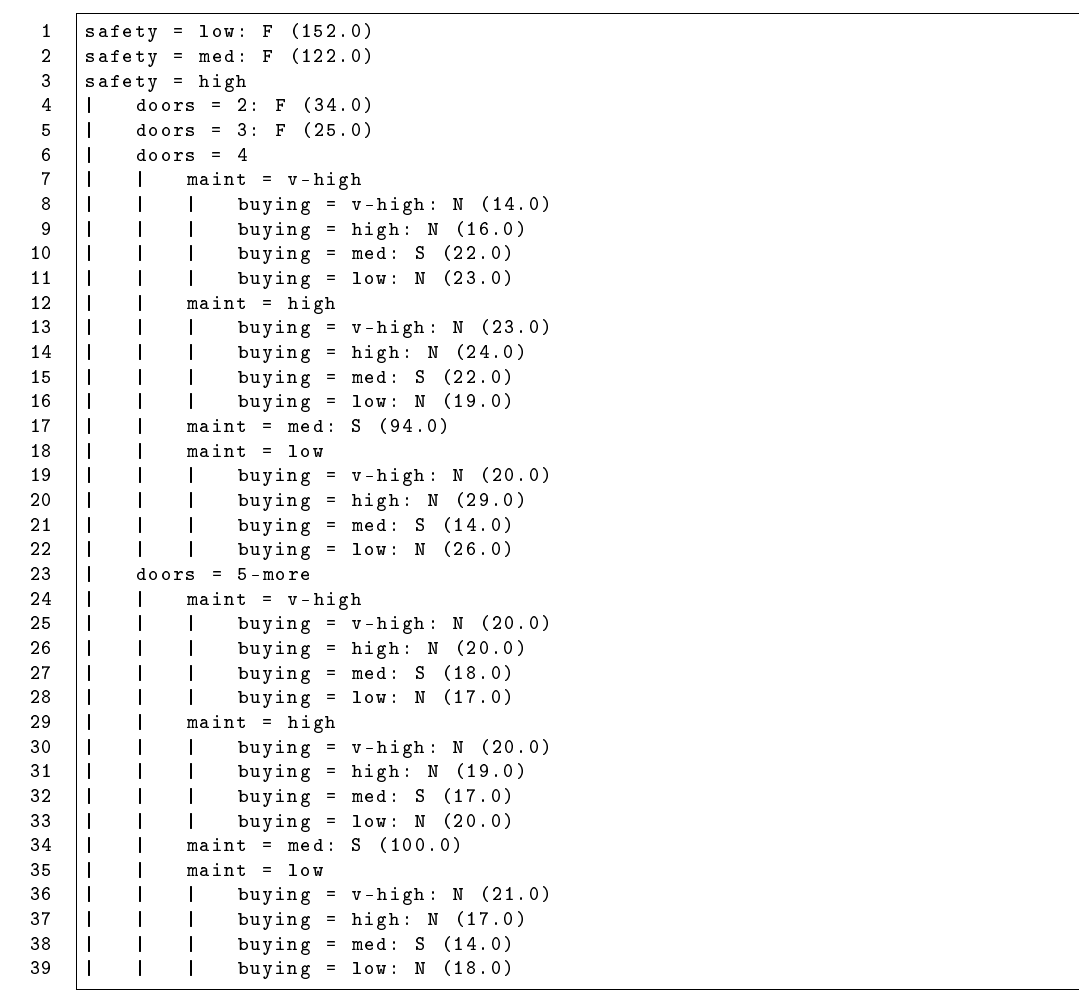
Figure 4. Protocol model of negotiations with C 3 after changing its preferences to C 1 ’s preferences. Model obtained using a decision tree algorithm (J48) with a dataset gathering 1000 negotiations. The notation “a = v : S/F/N” indicates that “if the term a has value v the negotiation succeeds, fails or is neutral.”. Every leaf includes the number of instances classified under a certain branch in parentheses.